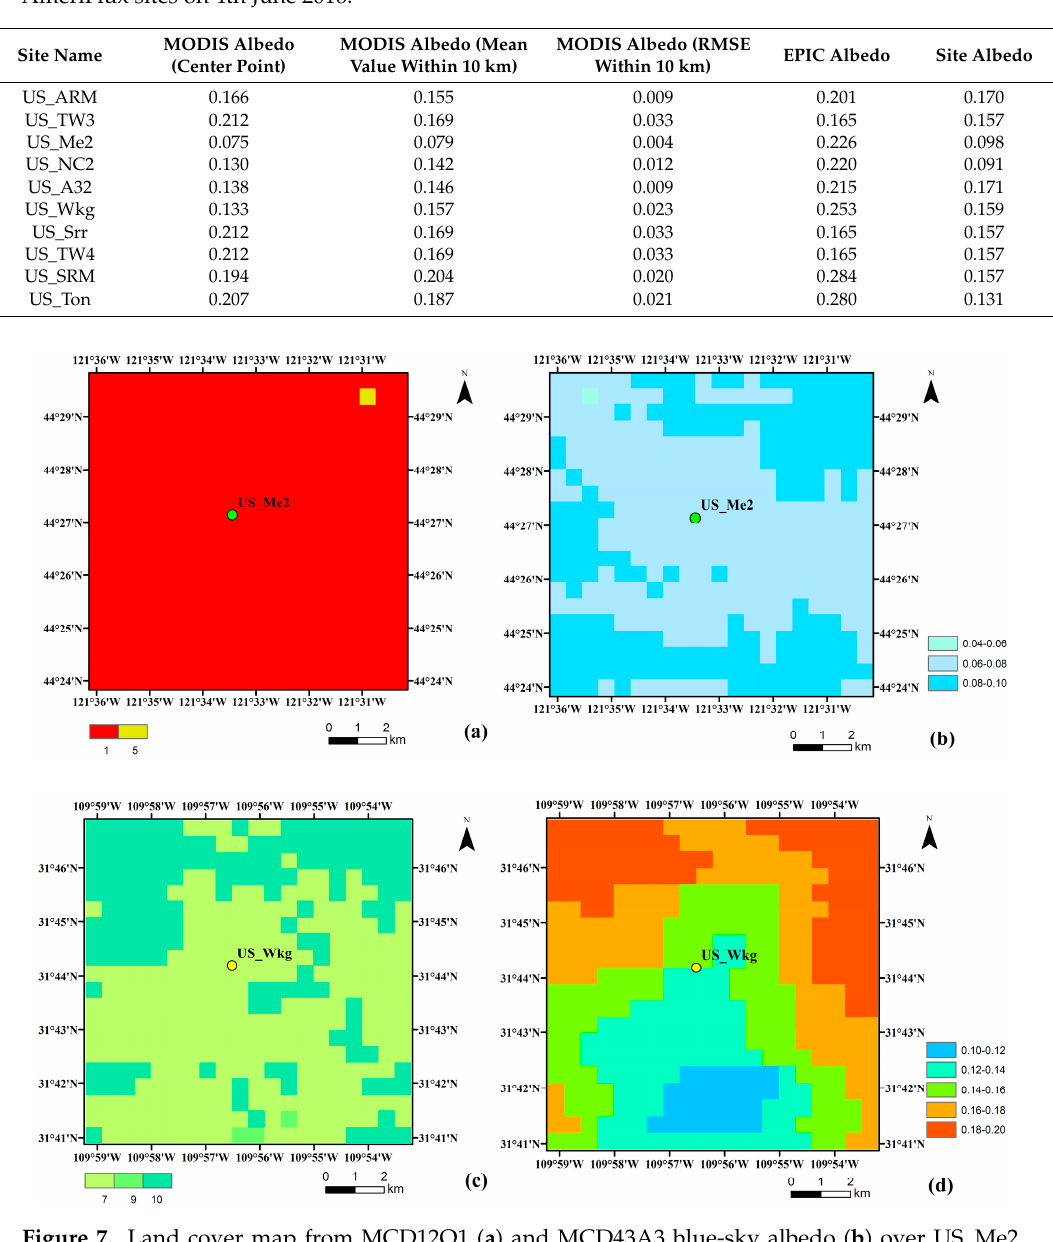
Table 3. Comparison of the MODIS albedo, the EPIC albedo and the ground-based albedo over the AmeriFlux sites on 4th June 2016.